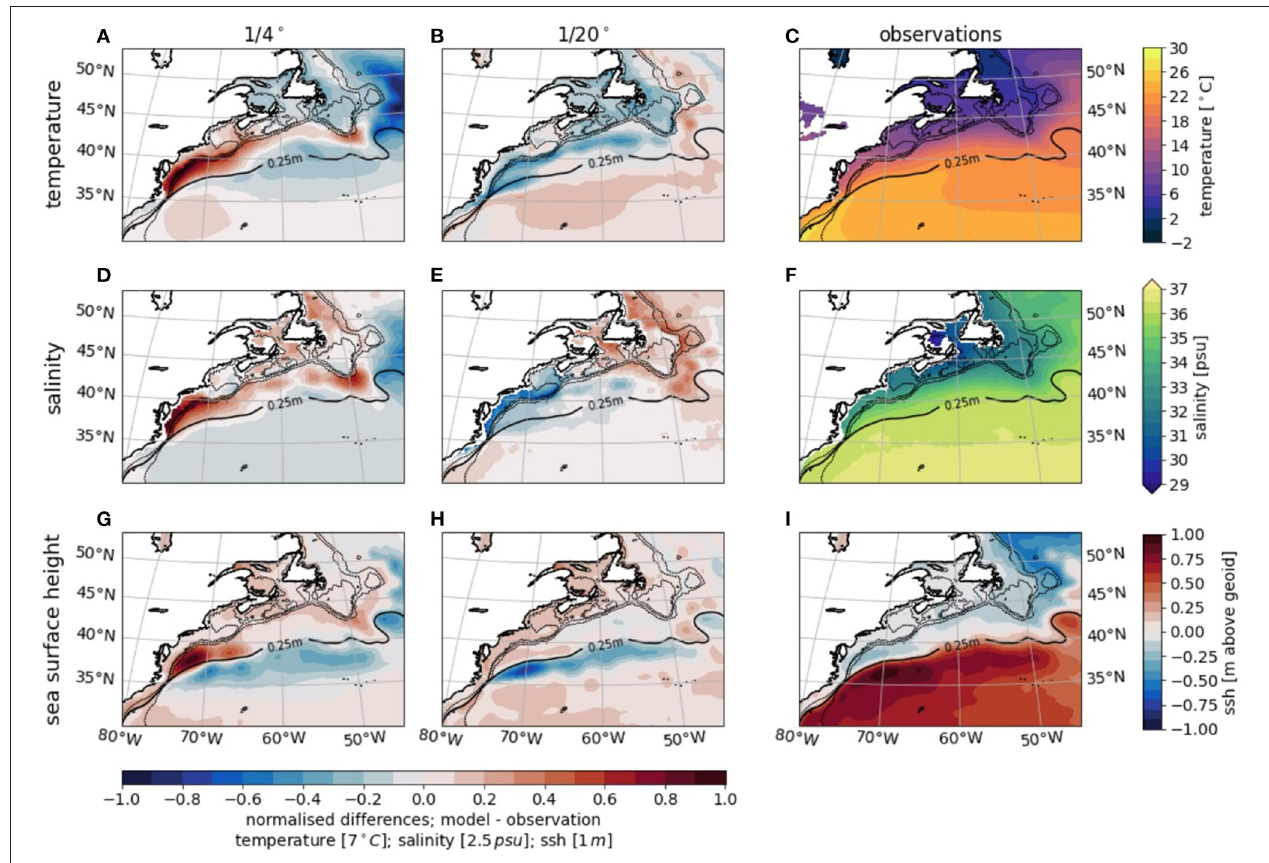
FIGURE 2 | Surface Validation; differences between SST (A,B) , SSS (D,E) , and SSH (G,H) of ORCA025 (A,D,G) and VIKING20X (B,E,H) to the Observations and absolute mean Observations [OISST (C) , SMOS (F) , and CMEMS (I) ] for the overlapping data periods from 1982 to 2019, 2010 to 2019, and 1993 to 2019, respectively; dashed lines indicate isobaths at 100, 500, and 2,000 m depth, each panel shows the CMEMS 0.25m SSH contour line for